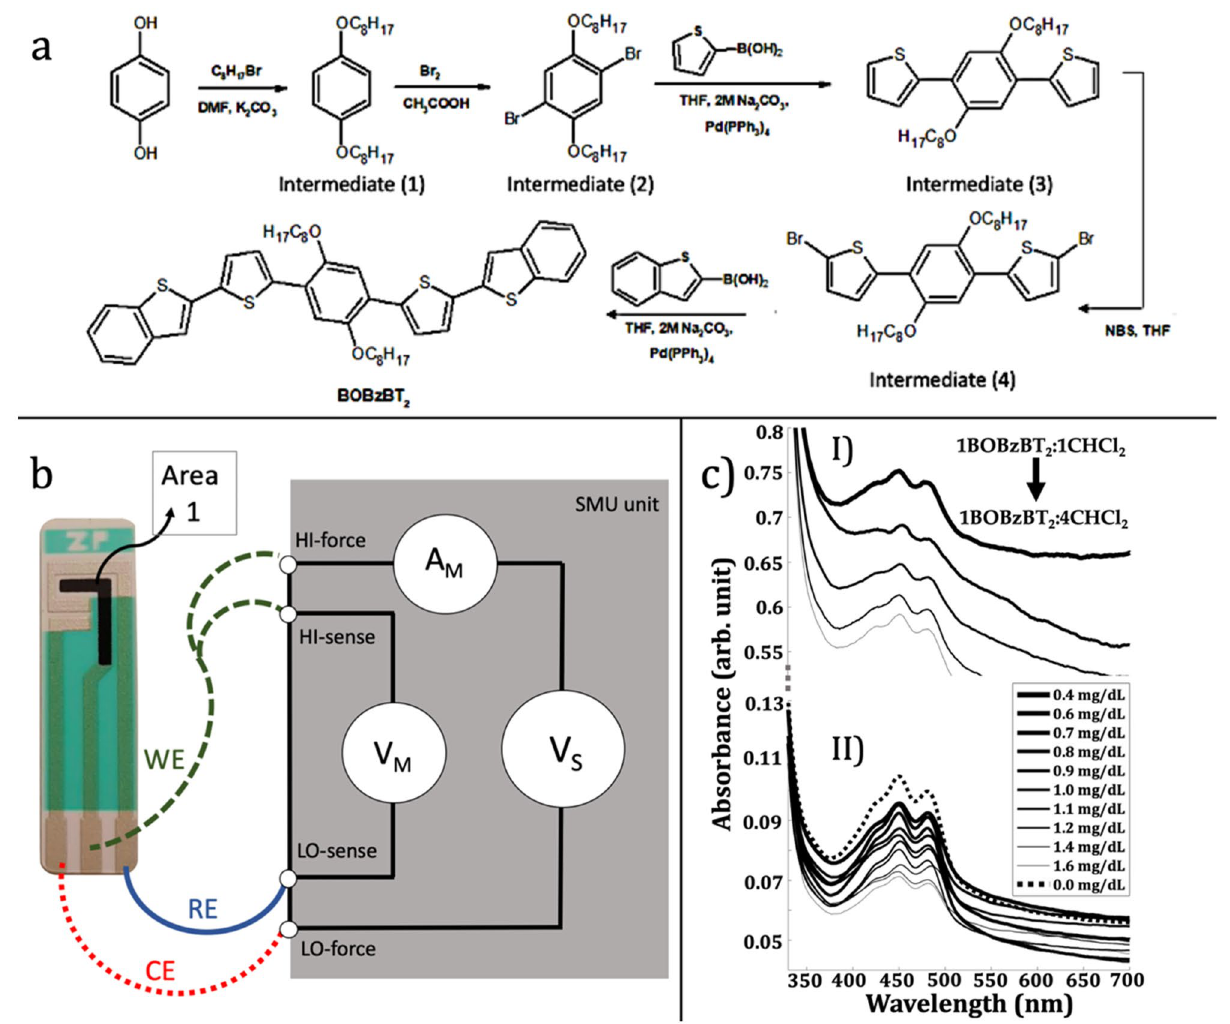
Figure 1. ( a ) The synthetic route of BOBzBT 2 . ( b ) The connection between the electrodes and the SMU instrument where the carbon working electrode (WE) was modified by drop-casting with 2.5µL BOBzBT 2 dilution (Area 1). The counter electrode (CE) and the reference electrode (RE) are made from Ag/AgCl. ( c ) UV–VIS absorbance spectra for (I) five BOBzBT 2 :CHCl 3 dilutions and, (II) 3BOBzBT 2 :5CHCl 3 dilution with ten concentrations of creatinine including the blank solution (0.0 mg dL −1